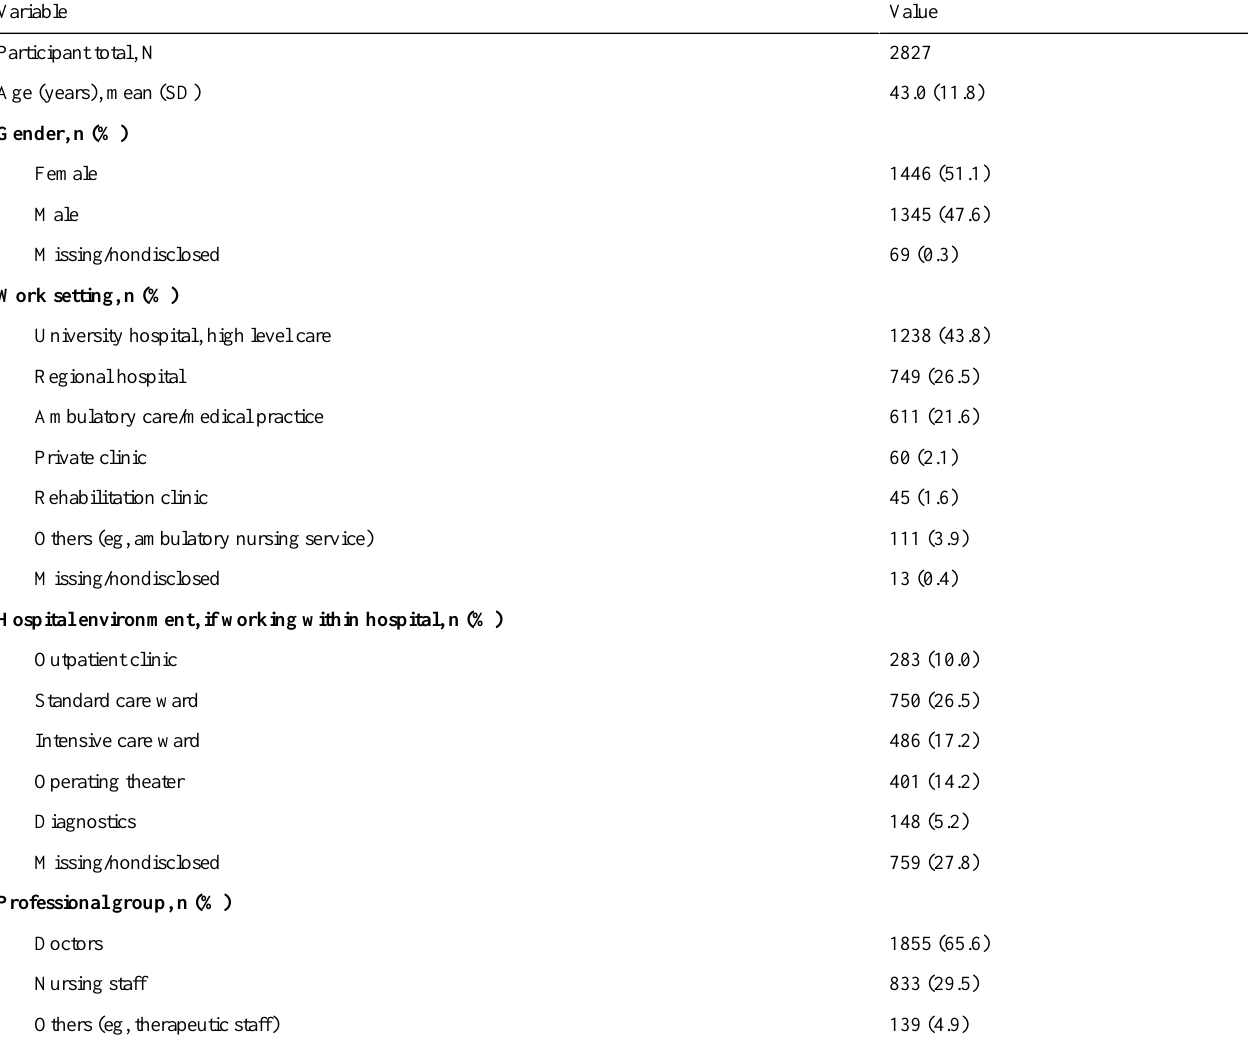
Table 1. Demographic data of the study